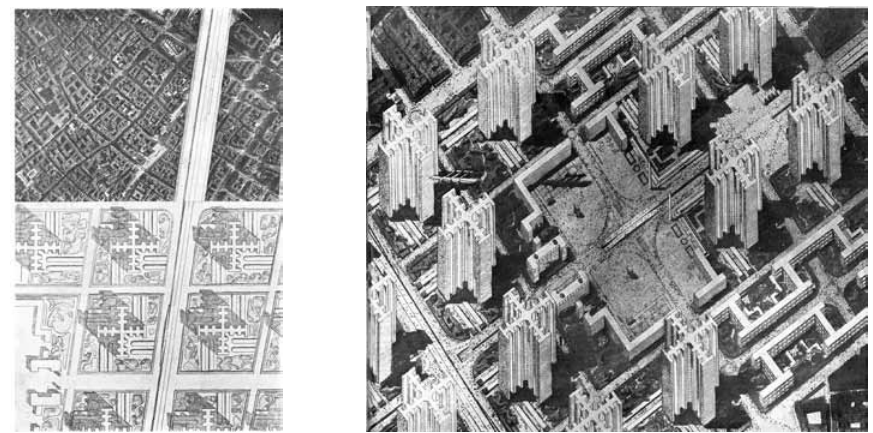
figs 8–9. Detailed fragment plan of Plan Voisin published in Urbanisme p. 273 and axonometric view published in Gesamtes Werk 1929, p. 116 © flC-aDaGP